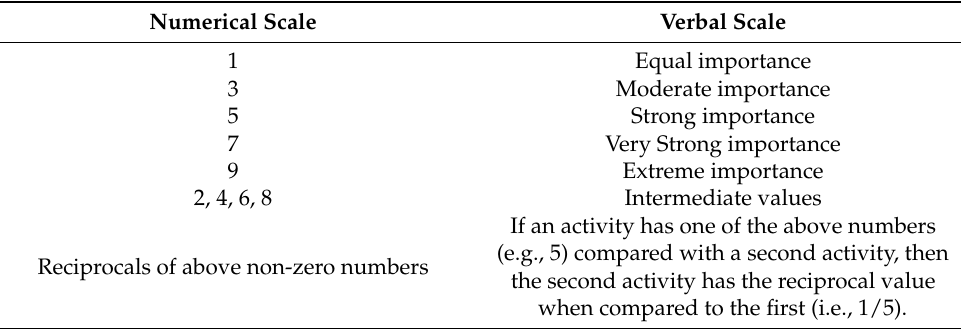
Table 3. Saaty’s fundamental scale